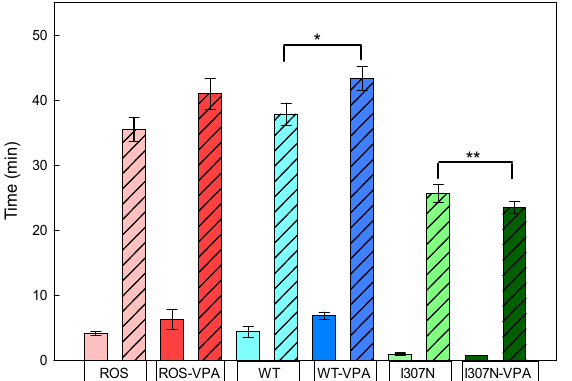
Figure 4. Thermal stability of the immunopurified ROS, WT, and I307N mutant Rhos at 48 °C. The thermal decay of the visible band was followed with time and the corresponding curves were fit to an exponential decay function with two components. The t 1/2 for the fast (solid color) and the t 1/2 for the slow component (hatched bar) were derived and are plotted for the non-treated (ROS—pink; WT—light blue; I307N—light green) and VPA-treated samples (ROS—red color; WT—dark blue; I307N—dark green) as indicated in the corresponding labels. The mean value and standard error (SE) were obtained in independent purifications ( n = 3). Treatment with VPA results in a small, but significant, increase in the thermal stability of WT Rho (*), and a small but non-significant decrease in the case of the I307N Rho mutant (**) ( p <